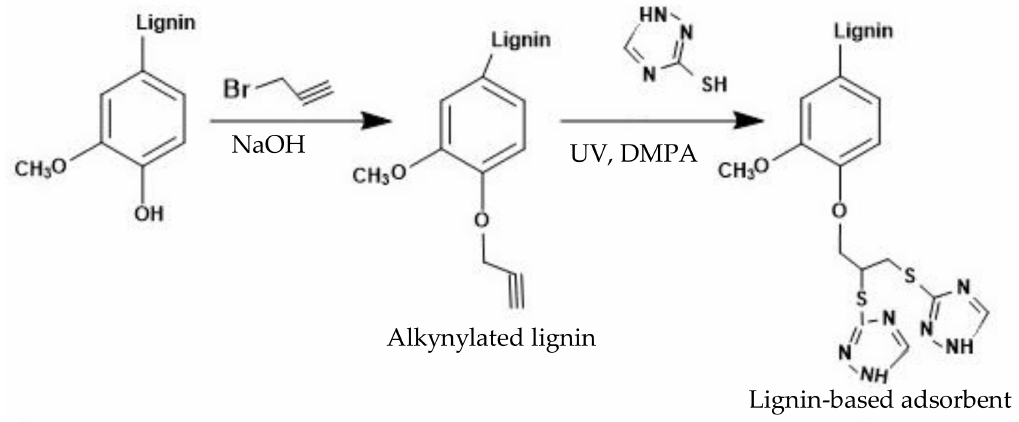
Figure 4. Schematic reaction mechanism of thiol-yne alkynylation lignin